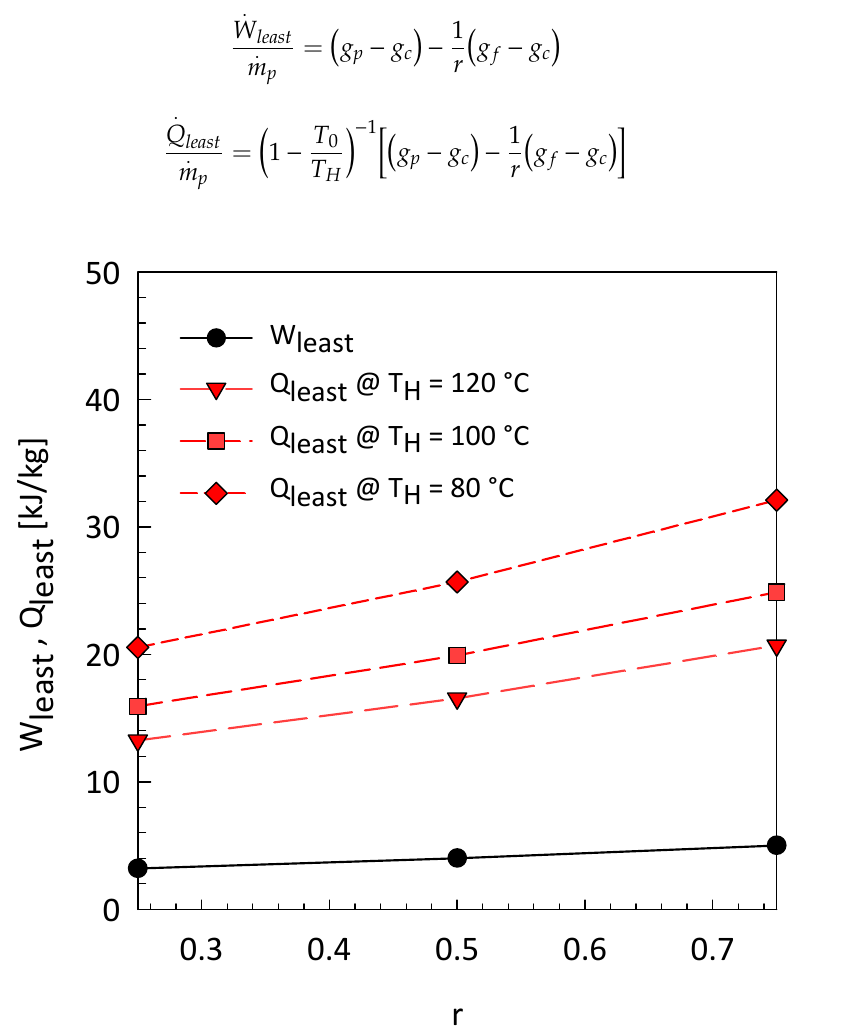
Figure 1. Minimum thermal and electrical energy for the separation of freshwater (product) from seawater (feed salinity at 35,000 ppm and environmental temperature T 0 = 25 °C) in relation to the recovery ratio, r.